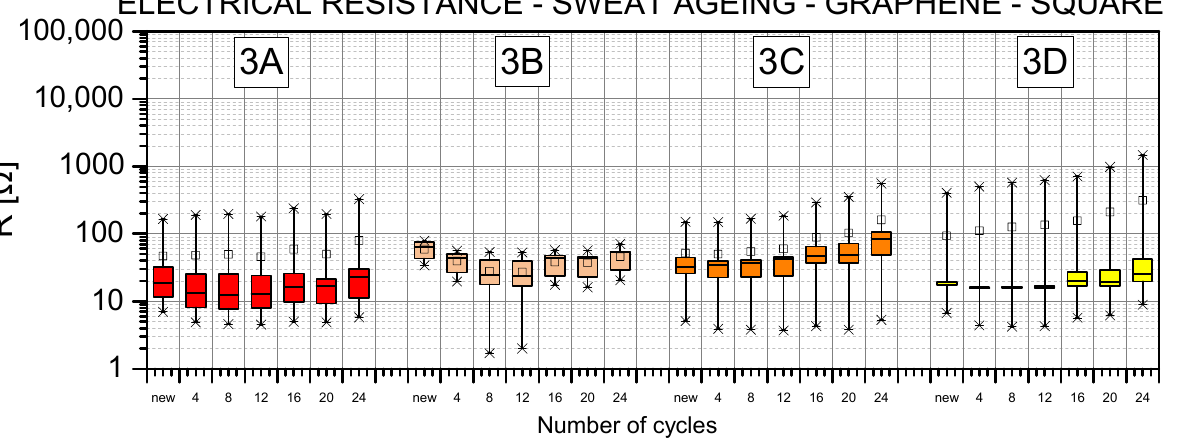
Figure 13. Repeatability of the graphene-based, rectangle-type sensor exposed to three identical humidity cycles.